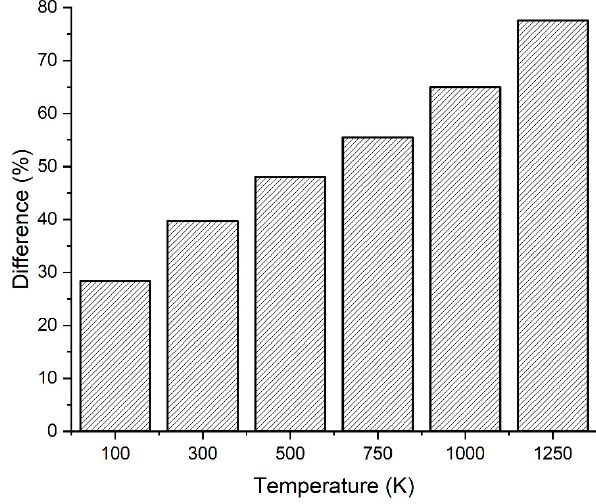
Figure 11. Variation curve of difference between ultimate stress and maximum stress with temperature.